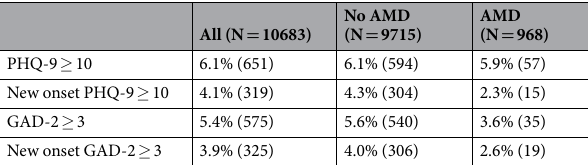
Table 8. Prevalence and new onset of depression and generalized anxiety in participants with and without AMD after excluding participants under treatment with antidepressants or anxiolytics. Abbreviations: AMD (age-related macular degeneration), PHQ-9 (Patient Health Questionnaire), GAD-2 (Generalized Anxiety Disorder Scale). PHQ-9 ≥ 10 defined as caseness for depression, GAD-2 ≥ 3 defined as caseness for generalized anxiety.